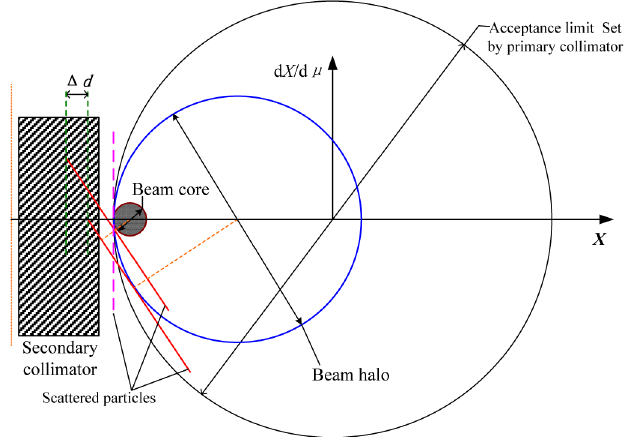
FIG. 11. Impact depth of scattered particles at the secondary momentum collimator is higher for beam core than for beam halo (in normalized emittance).